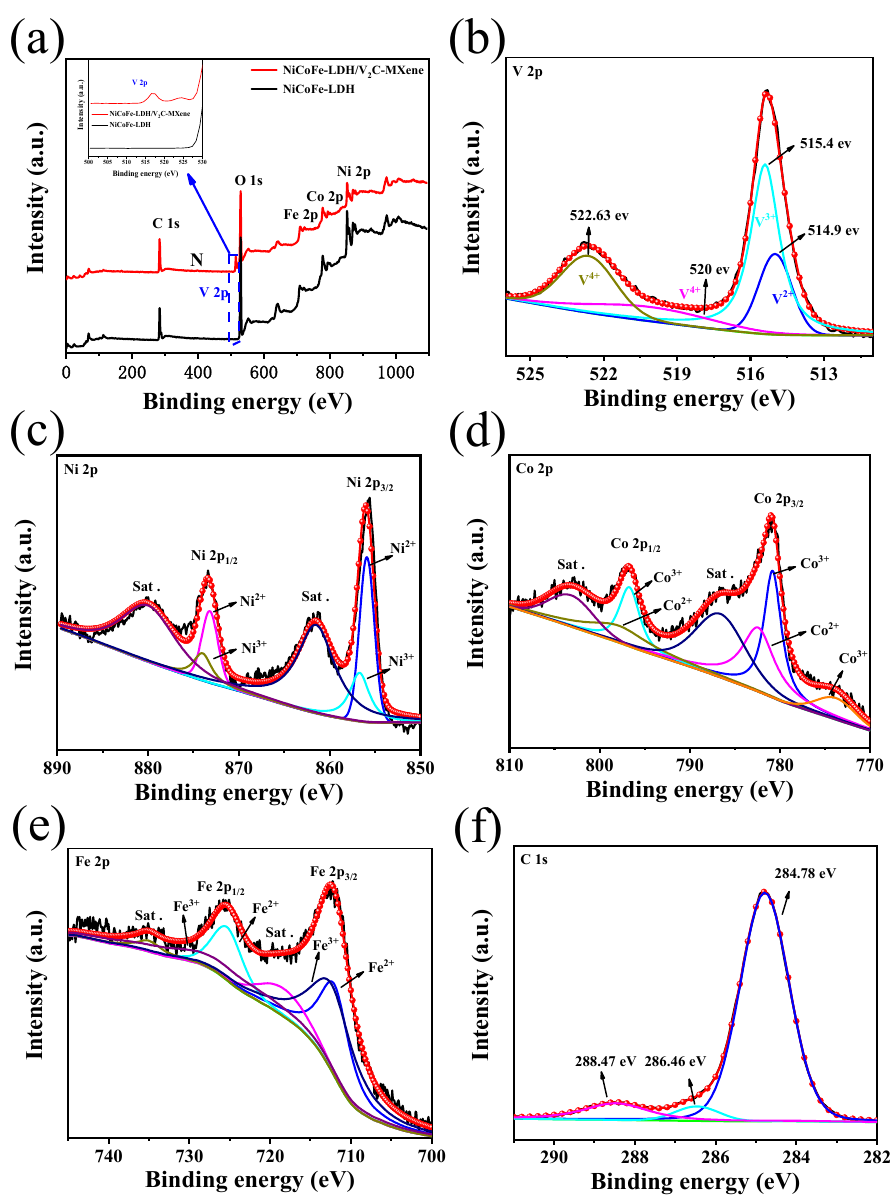
and 725.4 eV for 2p 1/2 and 2p 3/2 , respectively, are visible in the Fe 2p spectrum shown in Figure 5e. The asymmetry of the spectral peak positions reveals the presence of two valence states of Fe 2+ and Fe 3+ [25]. In the C 1s spectrum shown in Figure 5f, three peaks corresponding to binding energies of 284.78, 286.46, and 288.47 eV are visible. The highest intensity of these peaks is at a binding energy of 284.78 eV, which is for the sp 2 -hybridized graphitic carbon [26]. The two peaks at 286.46 and 288.47 eV correspond to defects and C=O, respectively [27,28].